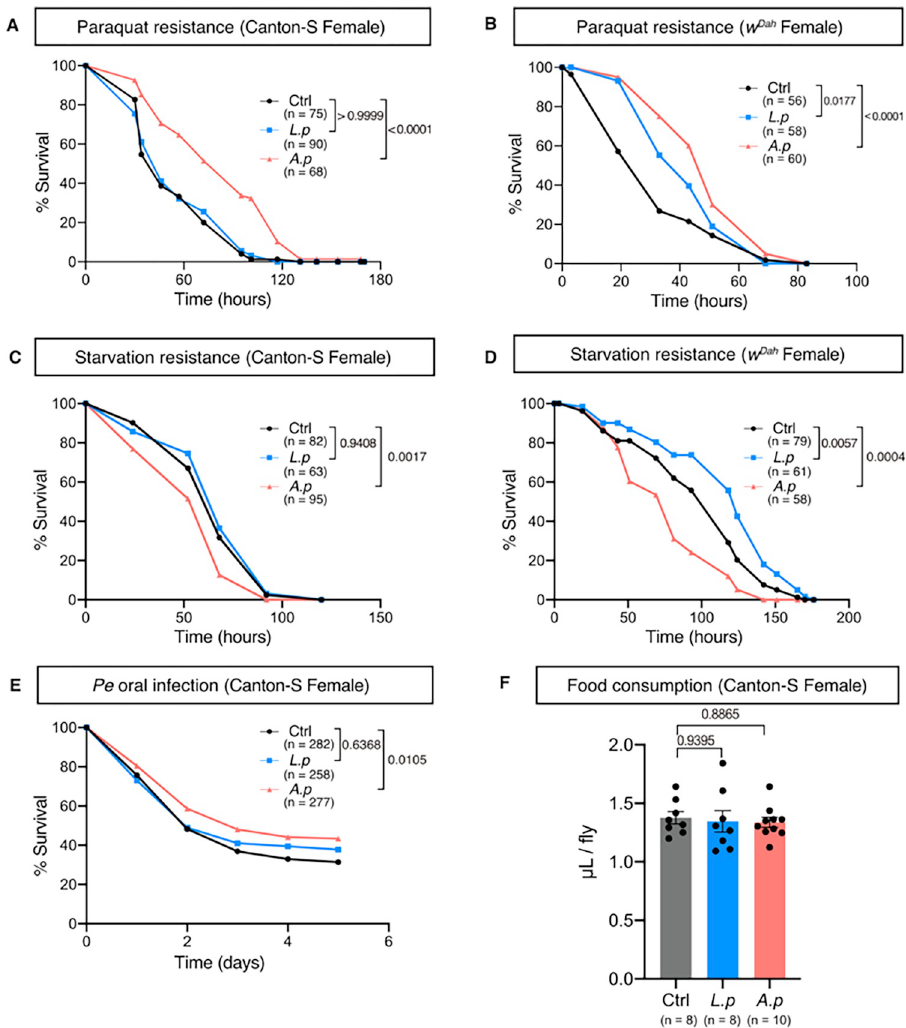
Fig 2. A . persici -conditioned diet enhances resistance to paraquat and Pe oral infection but susceptibility to starvation. (A)(B) Survival curve of female Canton-S (A) and w Dah (B) flies during 10 mM paraquat feeding after 5 days of a bacteria-conditioned diet (BacD). (C)(D) Survival curve of female Canton-S (C) and w Dah (D) flies during starvation stress after 5 days of BacD. (E) Survival curve of female Canton-S flies orally infected with Pseudomonas entomophila (Pe) after 5 days of BacD. A log-rank test was used to compare between control (Ctrl) and each BacD. (F) Food consumption of female flies by CAFE assay. Flies were treated with BacD for five days. Each point shows data of 7 or 8 flies. For the statistics, One-way ANOVA with Holm-Sˇı´da´k’s multiple comparison was used. The control diet followed the same procedure for BacD but it has only MRS broth in place of bacterial isolates, resulting in the antibiotics-contained diet. Sample sizes (n) and P values are in each